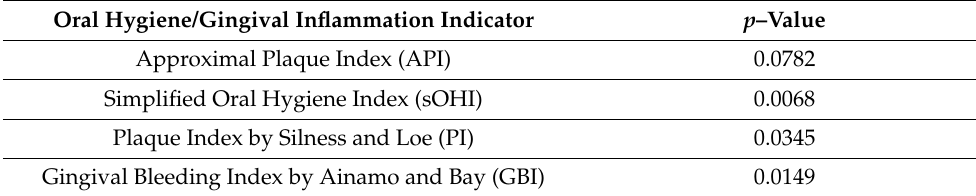
Table 2. Statistical significance of individual examined indicators. Oral Hygiene/Gingival Inflammation Indicator p –Value Approximal Plaque Index (API) 0.0782 Simplified Oral Hygiene Index (sOHI) 0.0068 Plaque Index by Silness and Loe (PI) 0.0345 Gingival Bleeding Index by Ainamo and Bay (GBI)